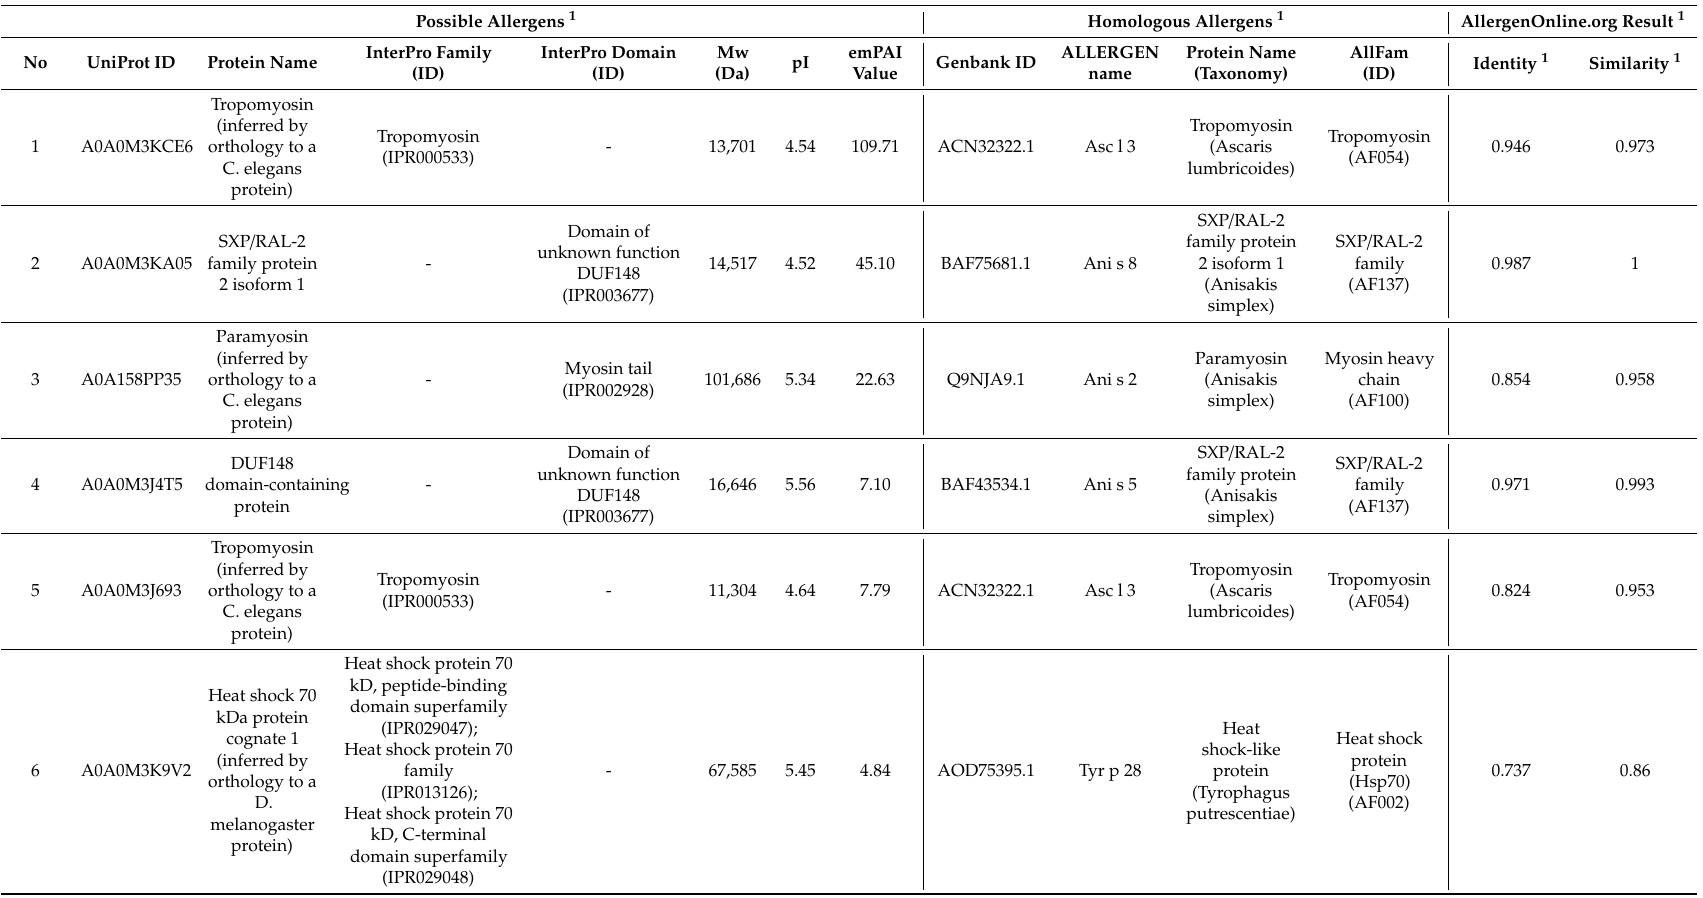
Table 3. Potential allergens of A. simplex identified by LC-MS / MS and AllergenOnline.org